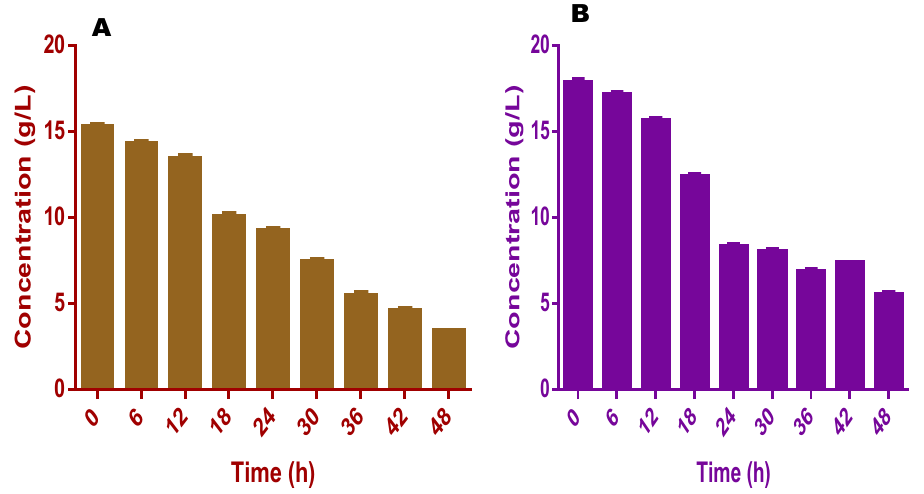
Figure 7. This figure shows the pattern of total soluble chemical oxygen demand (SCOD) conversion for ( A ) food wastes and ( B ) spent animal beddings during the